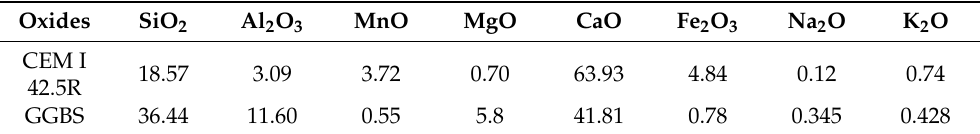
Table 1. Oxide content for cement CEM I 42.5R and (GGBS) (%).